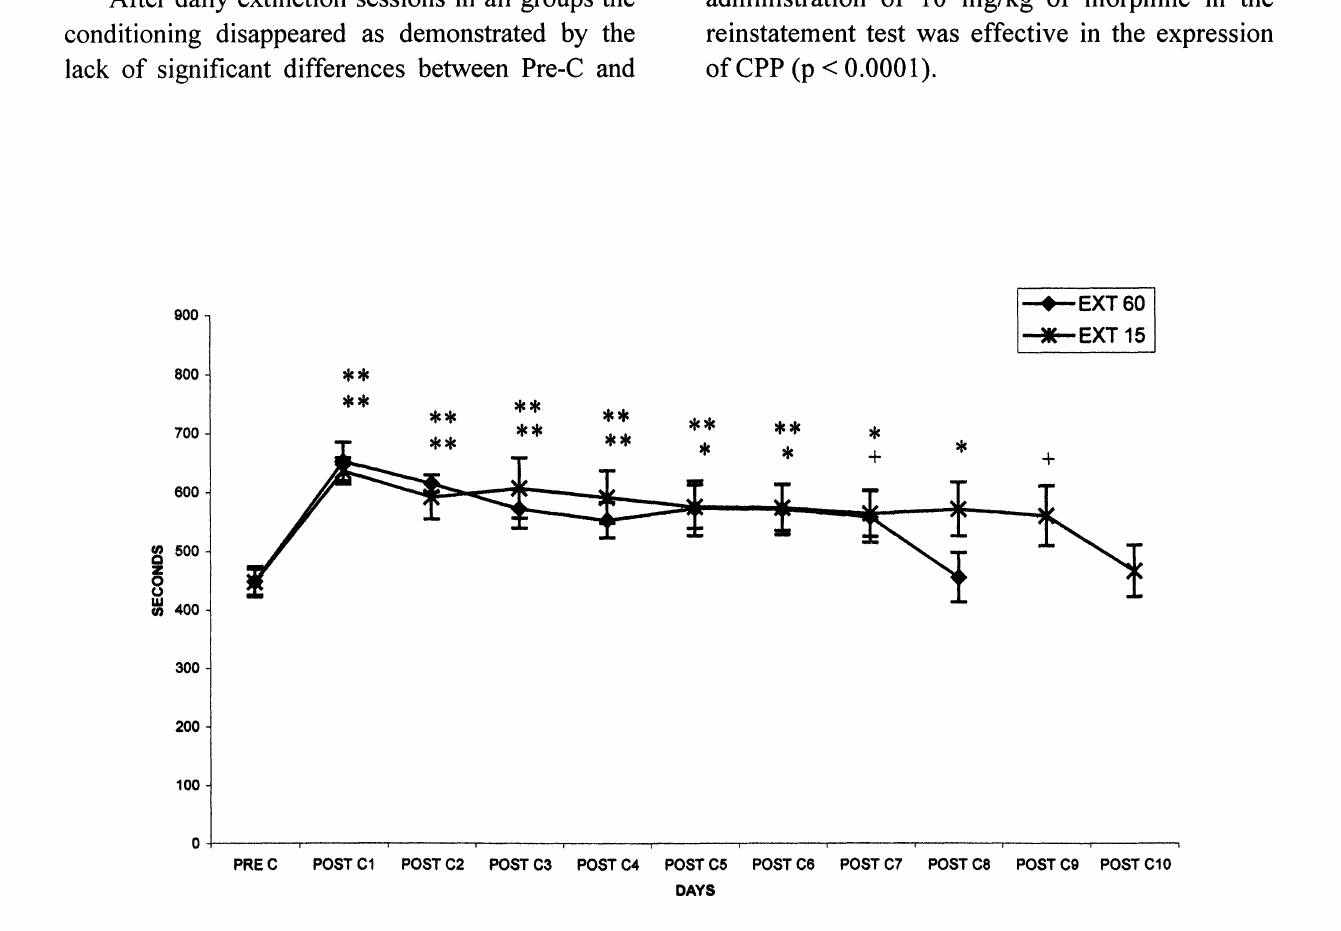
Fig. 2: C 10). Two different schedules of extinction were used: animals placed in the apparatus for 60 min (EXT 60) or for 15 min (EXT 15). ** p < 0.01, * p < 0.02, + p < 0.05, significant difference in the time spent in pre- conditioning vs. post-conditioning or extinction